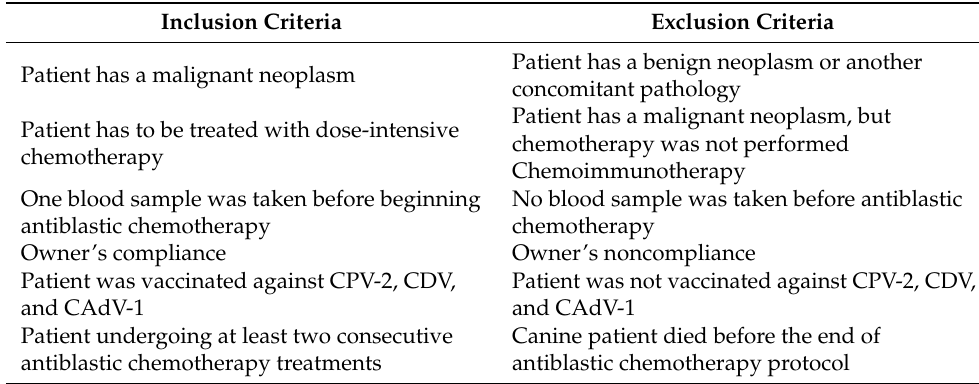
Table 1. Inclusion and exclusion criteria for the